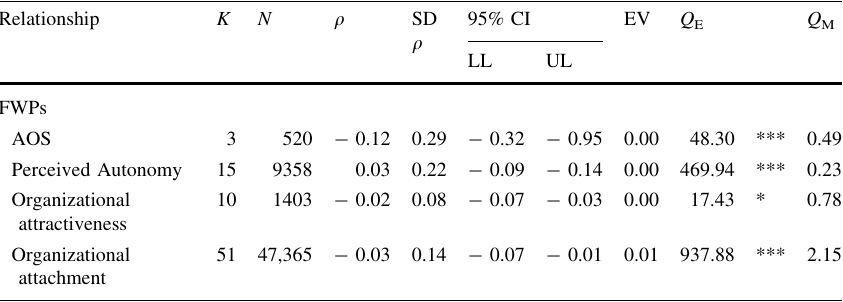
Table 9 Moderator analyses of the primary study quality (journal impact factor) on the relationships between FWPs and outcomes